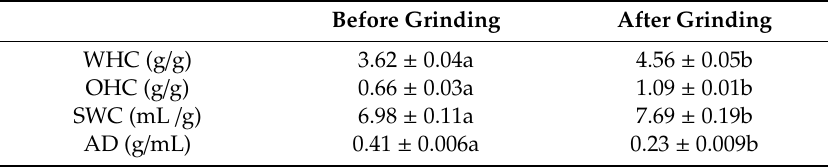
Table 1. Water-holding capacity (WHC), oil-holding capacity (OHC), swelling capacity (SWC) and apparent density (AD) of kiwifruit fiber. a.